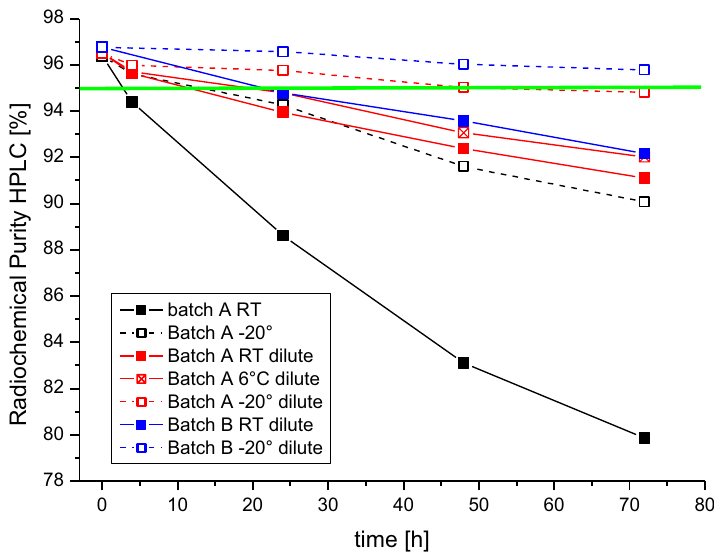
Fig. 2 Stability data for 2 batches of [ 177 Lu]Lu-PSMA I&T shown as radiochemical purity as determined by HPLC with different storage conditions and different dilutions. Green line indicates the limit of